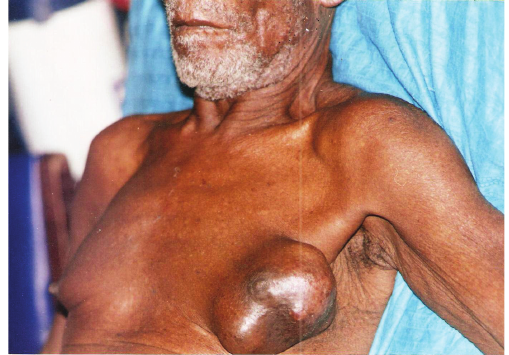
Figure 1: A hard central nontender mass in the left breast of a 64- year-old